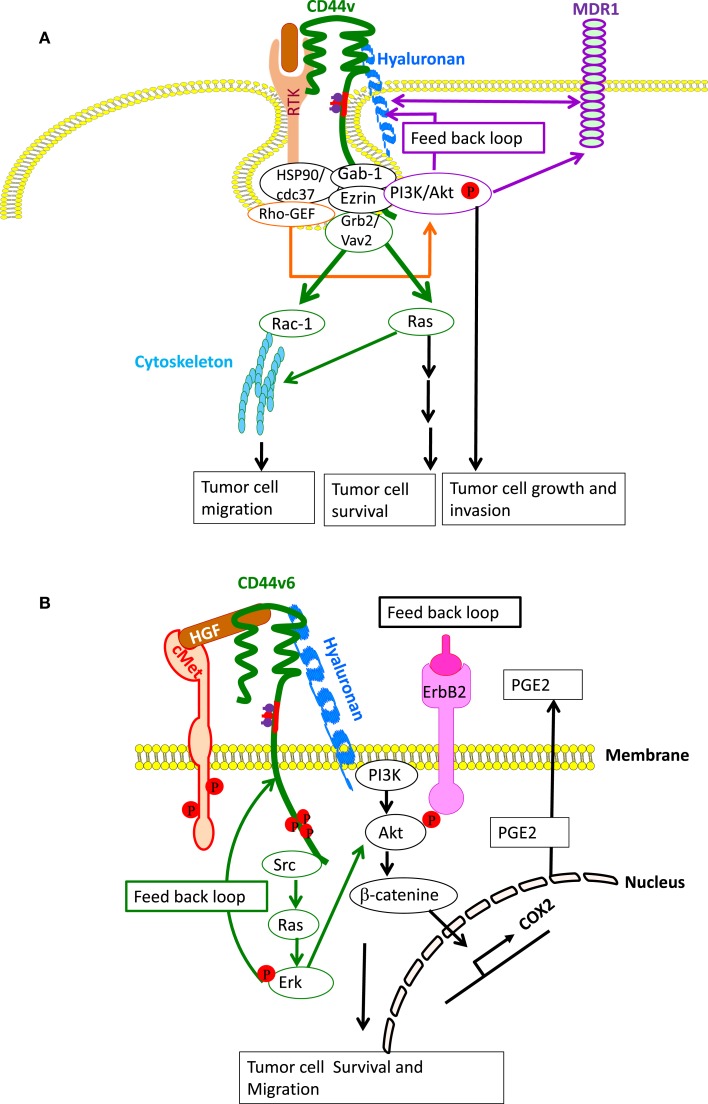
CD44- and CD44v-induced RTK for apoptosis resistance. (A) CD44-HA binding, accompanied by activation of CD44-associated SRC, ezrin phosphorylation, and PI3K activation leads to the lipid-raft-integrated assembly of a complex that includes heat shock protein 70 (HSP70), the co-chaperone CDC37, Rho-GEF, Grb2/VAV2, and Gab-1/PI3-kinase (PI3K), which promotes phosphorylation and activation of the receptor tyrosine kinases (RTKs), including ERBB2, ErbB3, EGFR, IGF1R-β, PDGFR-β, and c-MET. CD44-HA binding initiates cross-talk between RTKs, non-RTKs [SRC (Src)] and linker proteins. Studies have indicated that ErbB2 most likely complexes with CD44 via interactions with Grb2 and Vav2, whereas the interaction of PI3K and CD44 is mediated by Gab-1. PI3K activates Akt and downstream anti-apoptotic events, which contribute to drug resistance. However, HA and PI3K stimulate MDR1 expression, and the stimulatory effects of PI3K would be mainly due to its feedback stimulation of HA production by a positive feedback loop. Studies indicate that MDR1 is associated with CD44 in lipid microdomain and can be linked via CD44 with the actin cytoskeleton so that expression of both CD44 and MDR1 are concomitantly regulated. (B) Particularly, in colorectal cancer, the CD44–ERBB2 complex provides a strong apoptotic resistance through stimulation of cyclooxygenase 2 (COX2) transcription via PI3K and β-catenin. COX2-induced PGE2 stimulates HA synthesis and HA-CD44 signaling. CD44v6 also binds hepatocyte growth factor (HGF) and presents it to c-MET. Activation of MET and the downstream signaling cascades require sustained activation of CD44-associated phosphorylated ezrin, radixin, and moesin (ERM) and SRC (Src) signaling via the Ras-MAPK and the PI3K-Akt pathway. Ras-Erk pathway can augment CD44v6 synthesis through a feedback loop between CD44v6 and c-Met/Ras-Erk pathway.